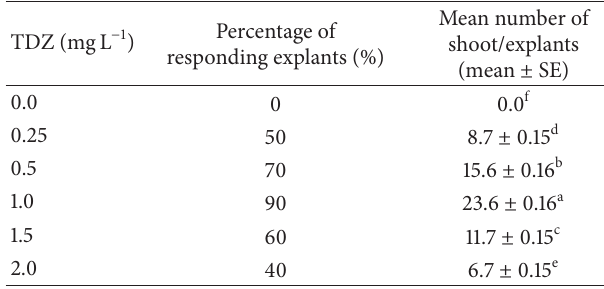
Table 1: Effect of TDZ on shoot regeneration from leaf explants